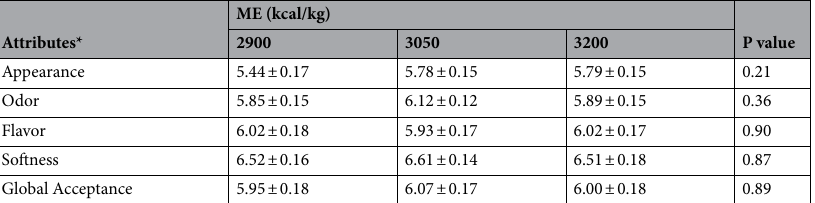
Table 6. Analysis of the sensory attributes of the breast fillet in relation to the levels of metabolizable energy (ME) in quail diet (49 days of age). *Score for each attribute—Hedonic scale form where 1 represents: I disliked a lot and 8 represents: I liked a lot (Dutcosky 33